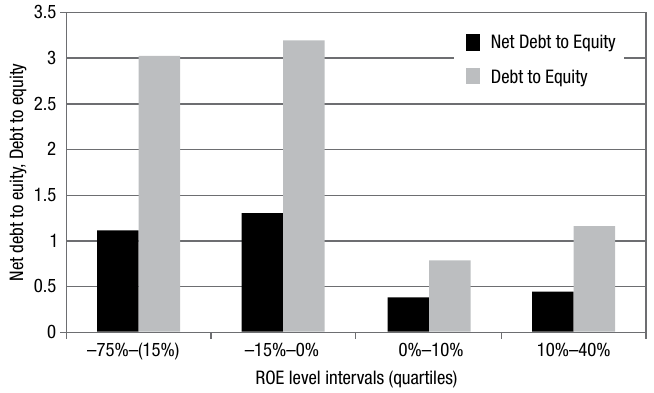
Fig. 2. Debt level according to ROE quartiles (FY 2010)